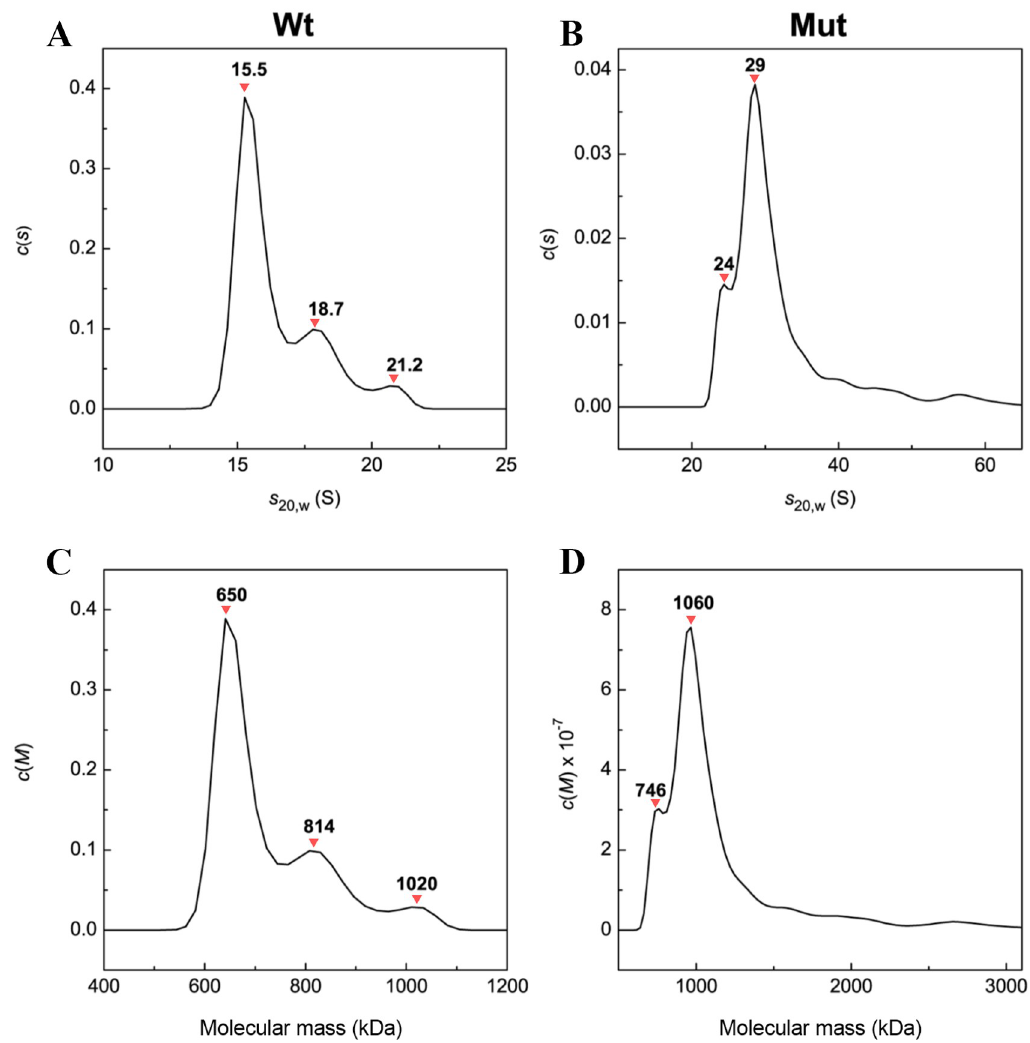
Fig 9. Analytical ultracentrifugation (AUC) analyses of different human α B-crystallin samples. Differential sedimentation coefficient distributions c ( s ) ( A and B ) and differential mass distribution c ( M ) ( C and D ) for α B-crystallin and D109A mutant at 20 ˚C. Rotor speed was 40,000